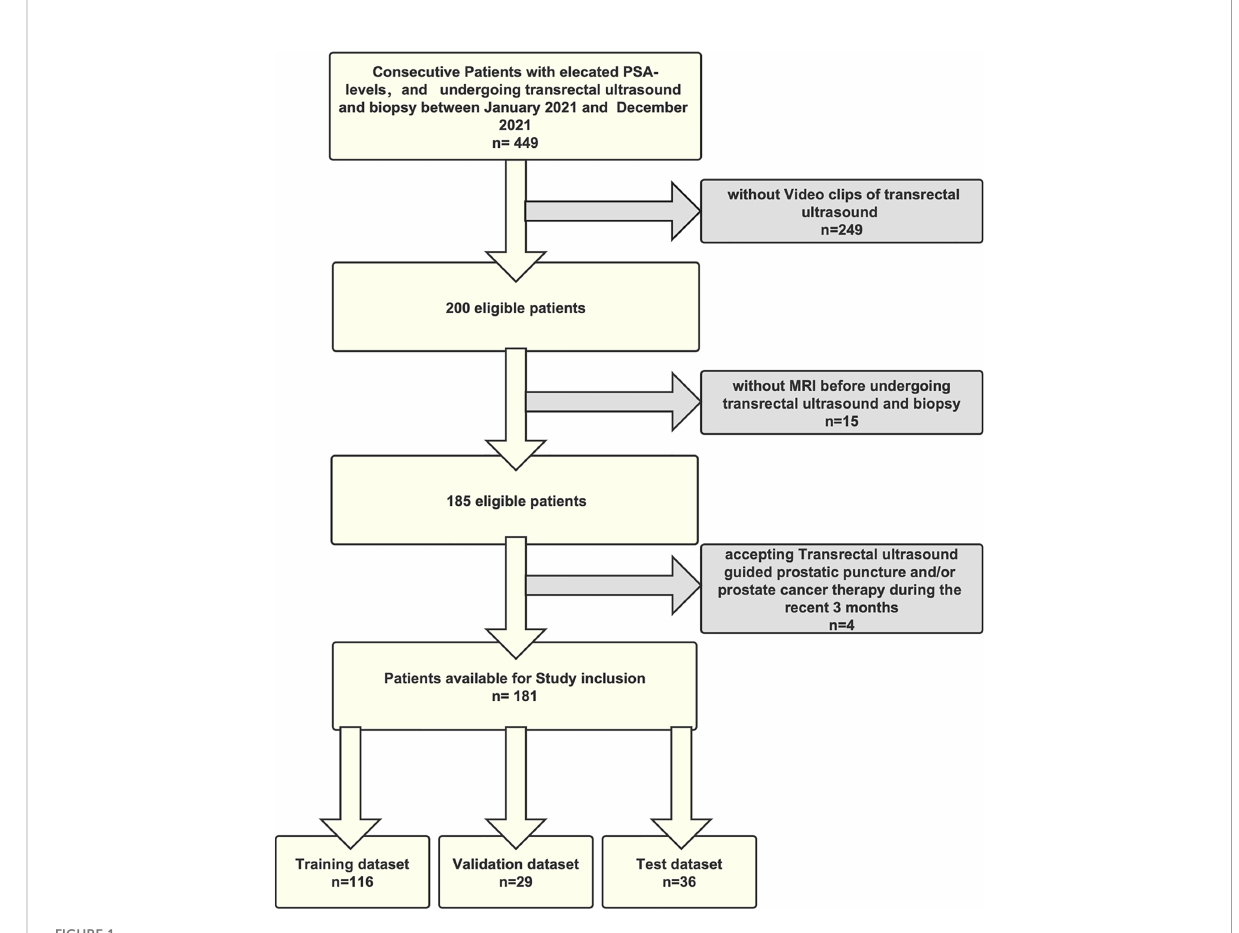
FIGURE 1 The fl owchart of inclusion and exclusion of the study